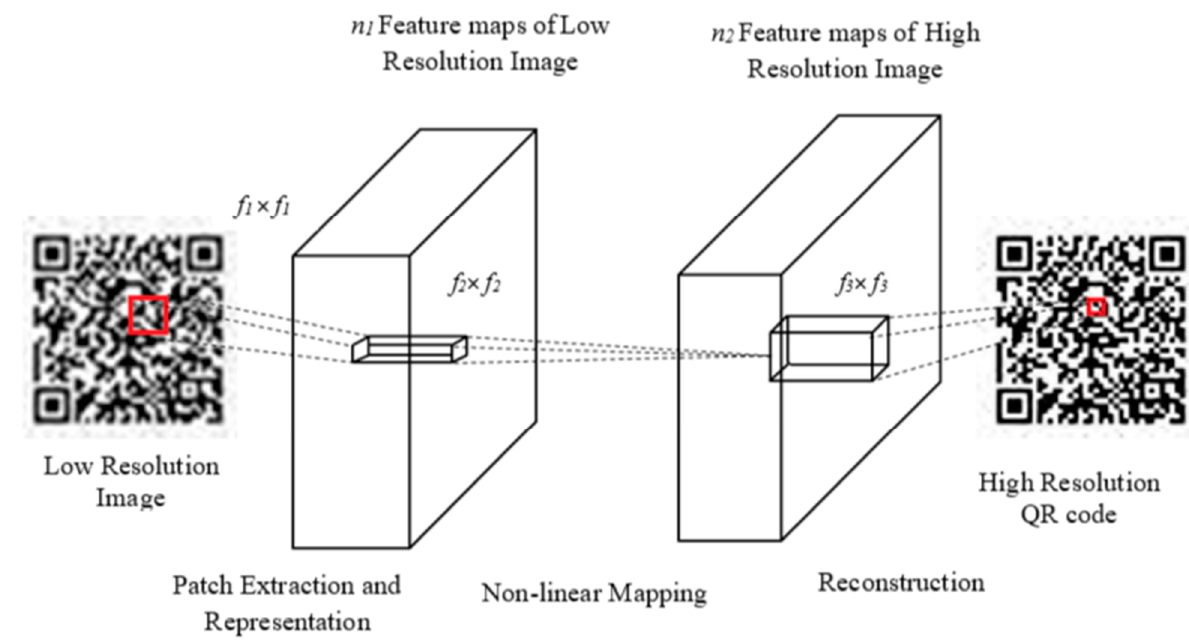
Figure 7. QR code super